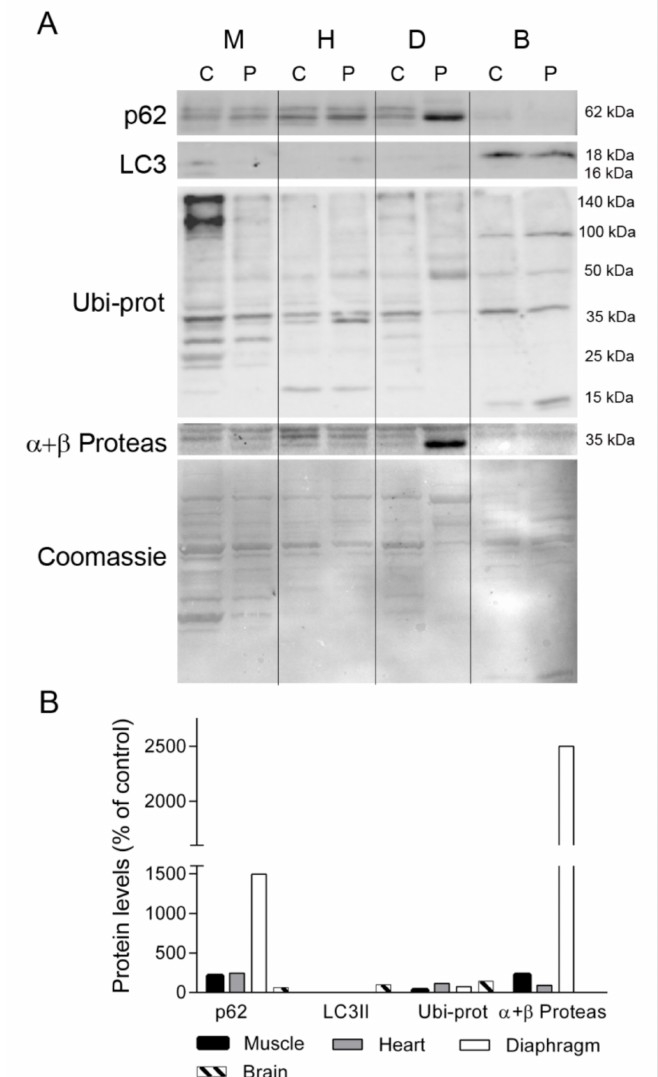
Figure 7. Autophagy and ubiquitin-proteasome system markers. ( A ) Representative Western blotting of autophagy and ubiquitin proteasome markers in tissue homogenates of a control (C, n = 1) and the patient (P). Shown below is a representative Coomassie blue-stained gel. ( B ) Densitometry analysis: protein levels were normalized to total protein loading according to Coomassie blue staining. Data are expressed as percentage of control values. Abbreviations: M, skeletal muscle; H, heart; D, diaphragm; B, brain; L, liver; K, kidney; I, small intestine. LC3, microtubule-associated proteins 1A/1B light chain 3A; Ubi-prots, ubiquitinated proteins; α + β Proteas, α and β catalytic subunits of the 26S